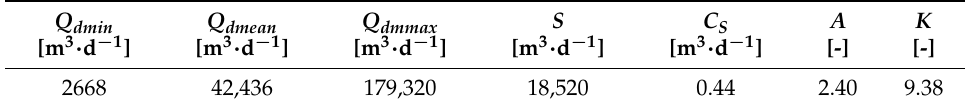
Table 1. The characteristics of the sewage outflow from the urban agglomeration of Radom in the years 2013–2015.